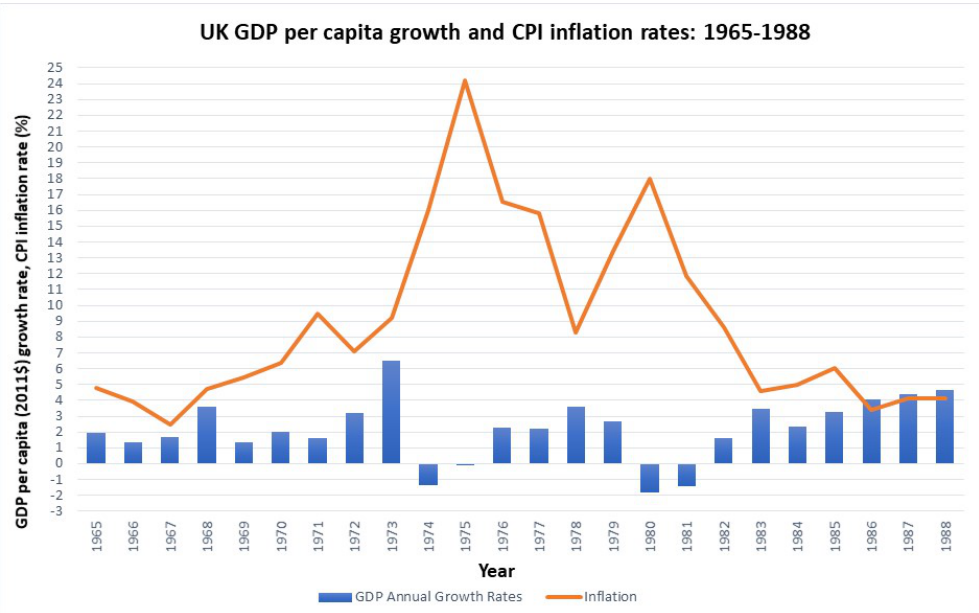
Figure 5. ‘Stagflation’ (1973–1981): Inflation skyrocketed and remained high, whilst GDP growth rates stagnated. (Deflationary policies in 1979 decreased inflation such that GDP growth was re-established in 1981 Q1 and inflation remained low).